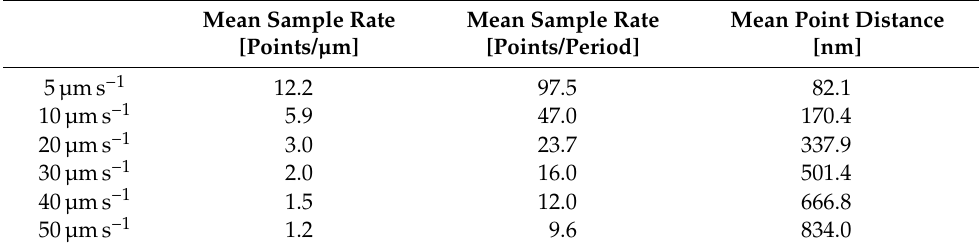
Table 1. Comparison of the sampling rate and the mean distance of the measuring points at different moving speeds. The period of the analyzed sample is 8